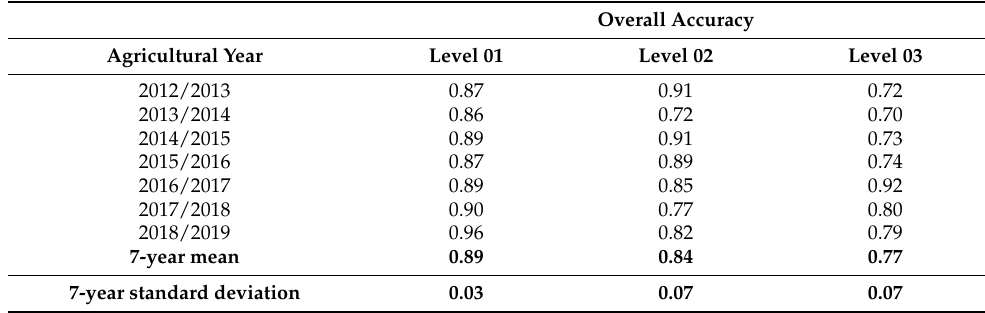
Table 3. Overall accuracy of the annual hierarchical classification of the cropping systems, at the three levels, for 7 years in Mato Grosso.